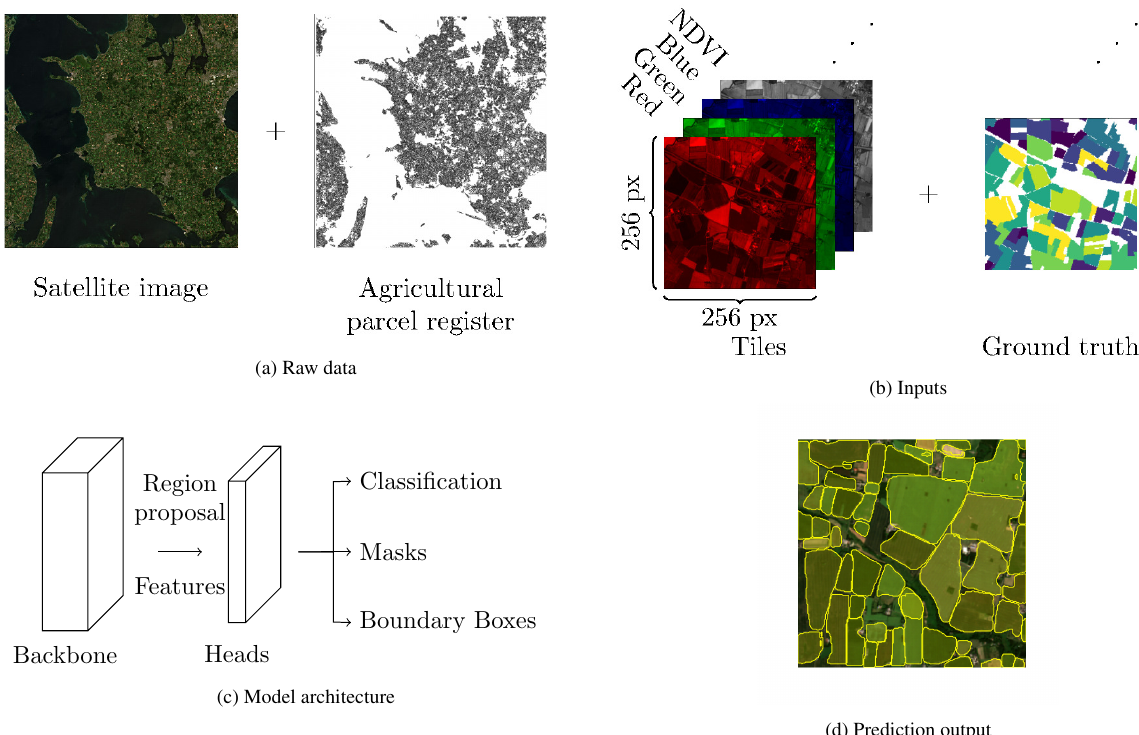
Figure 1. Training of the Mask R-CNN to predict field boundaries. From Sentinel-2 imagery and parcel register 1a, a dataset is generated 1b. The model 1c is then trained to predict field boundaries in new area